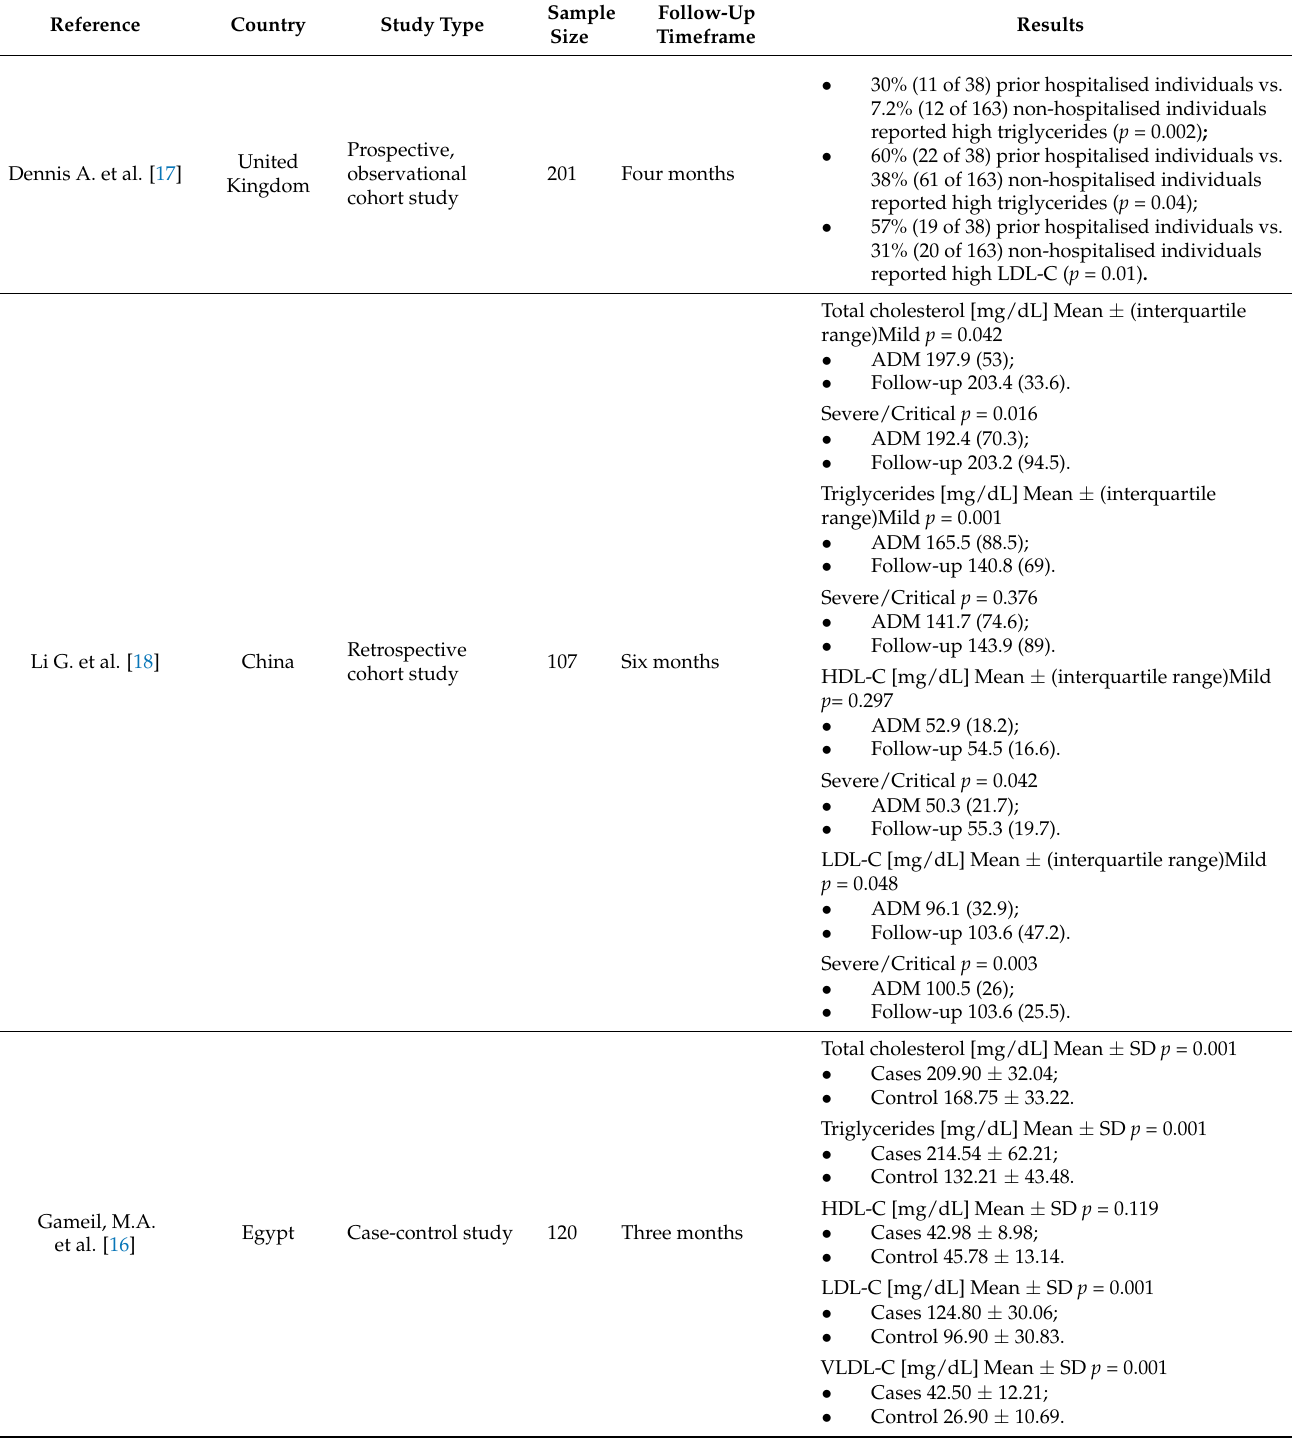
Table 3. Summary of studies investigating new-onset dyslipidaemia after COVID-19